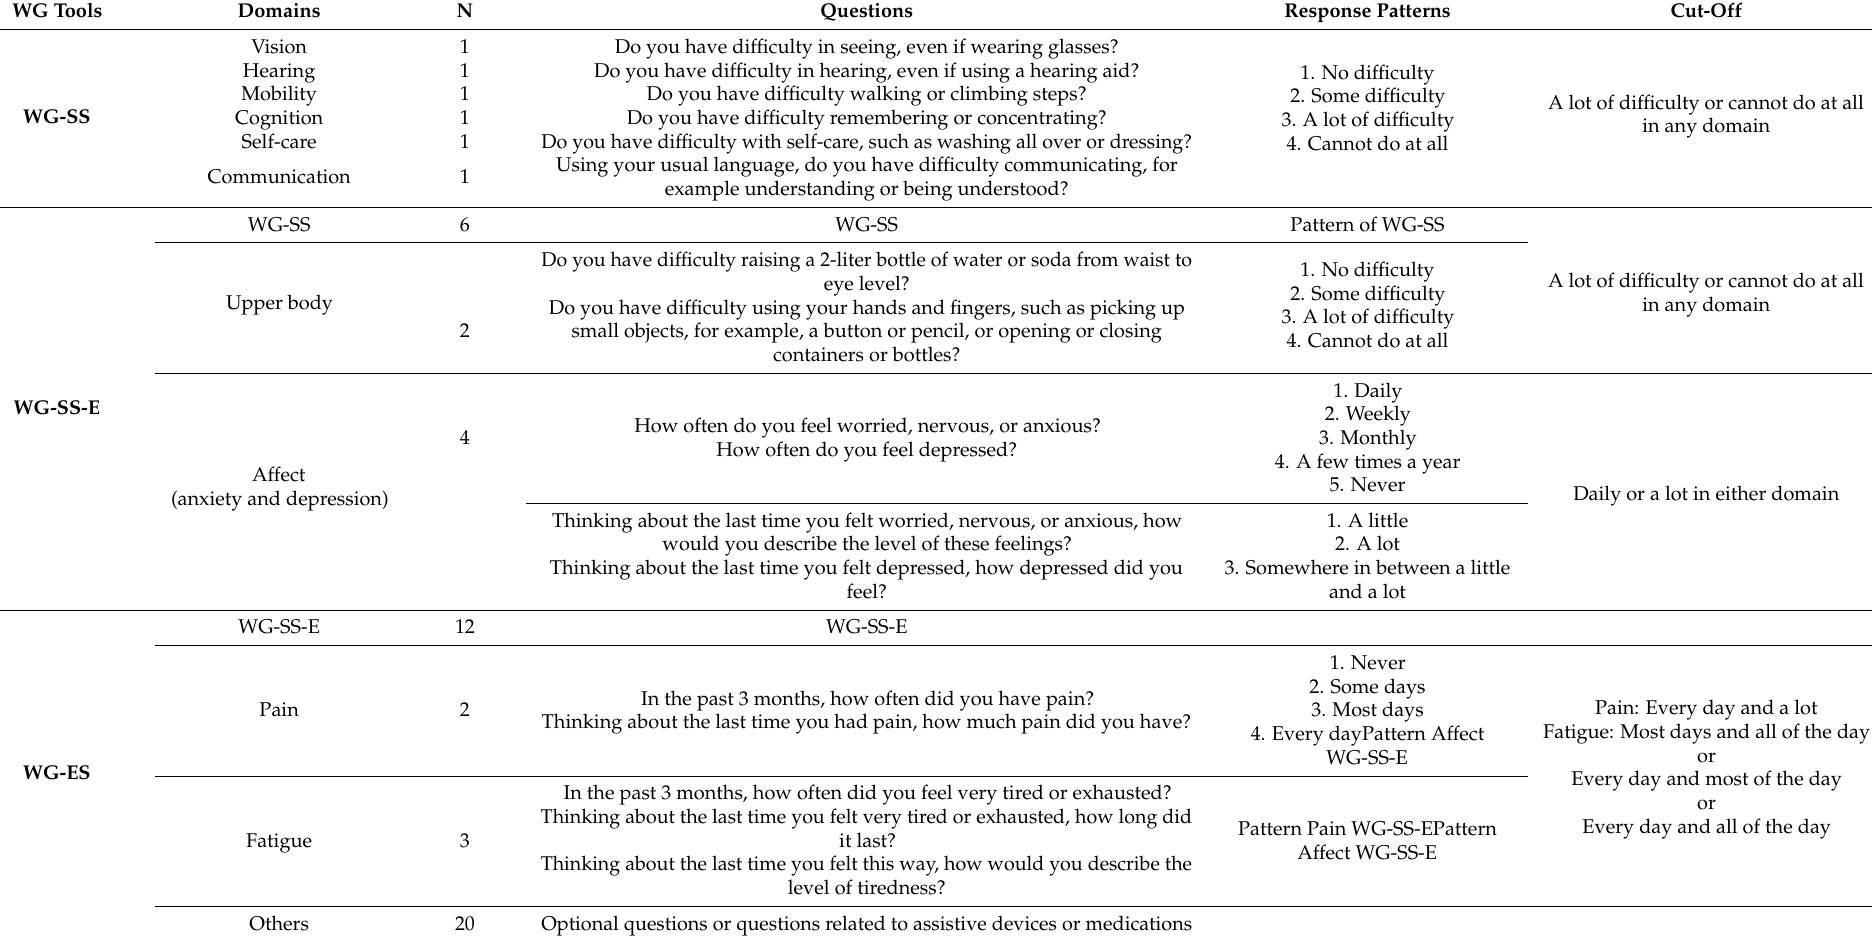
Table 1. Synthesis of the Washington Group